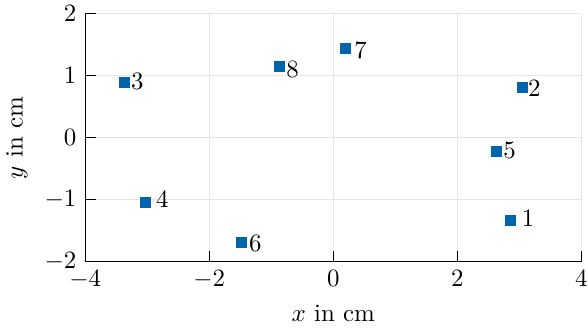
Figure 5. Antenna positions in the sparse array used for angle